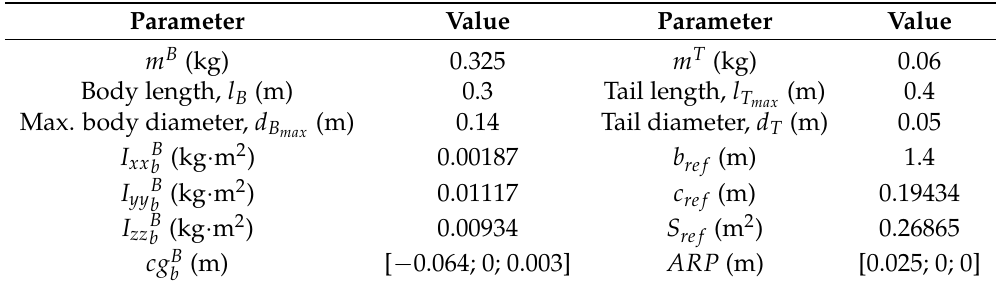
Table 1. Aircraft model physical properties